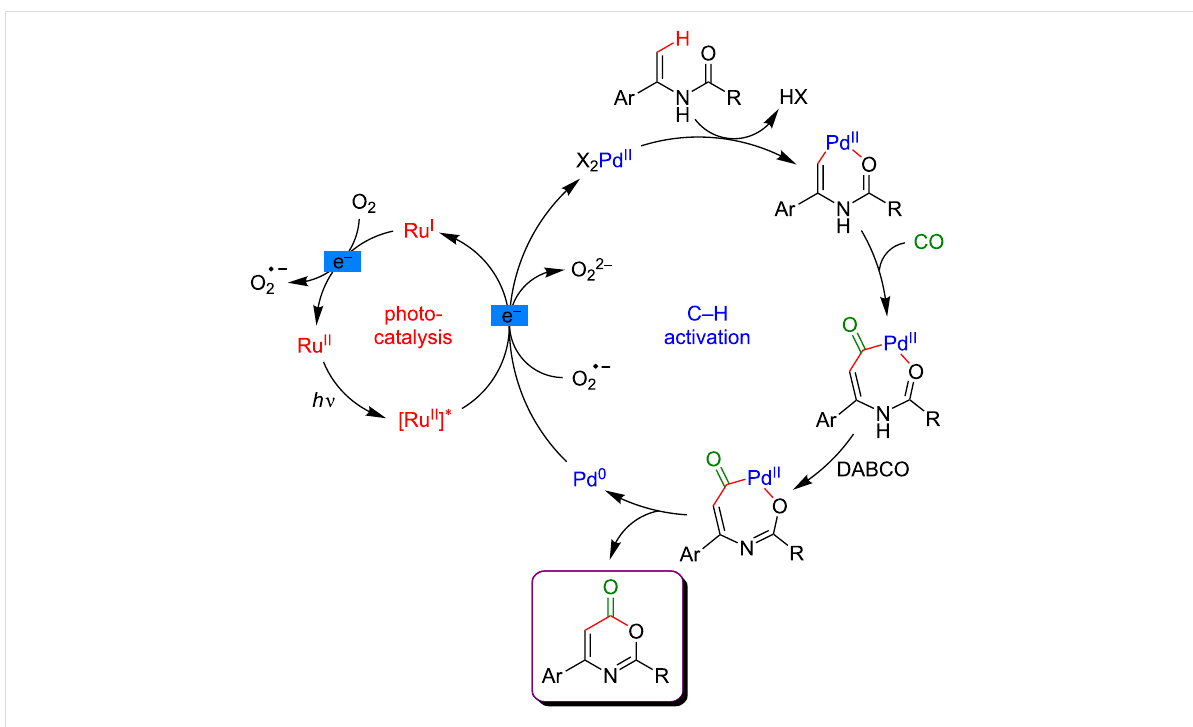
Figure 14: Proposed mechanism for carbonylation of enamides via dual catalysis.